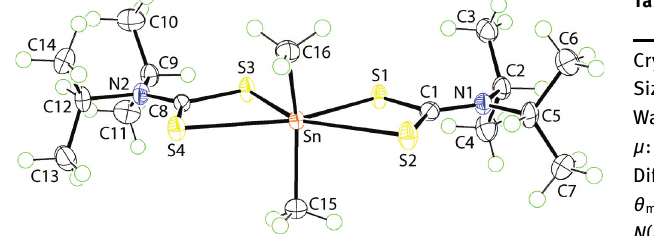
Table 1: Data collection and handling.